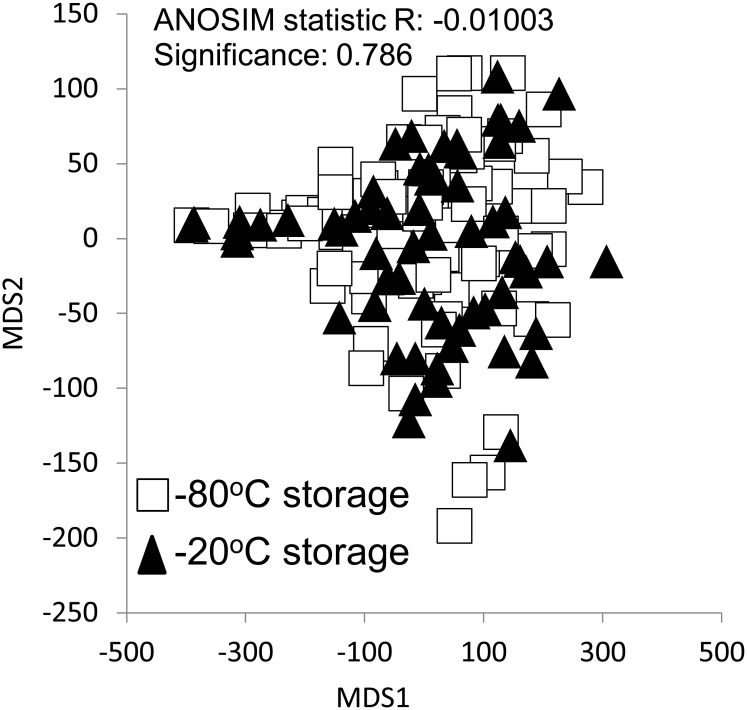
Comparison of the effect of soil storage temperature (-80°C vs. -20°C) on the 16S rRNA-based communities generated from soils collected from Hawaii.There was no significant effect of storage temperature on the communities examined at the phylum level (ANOSIM R = -0.01003, p = 0.786).